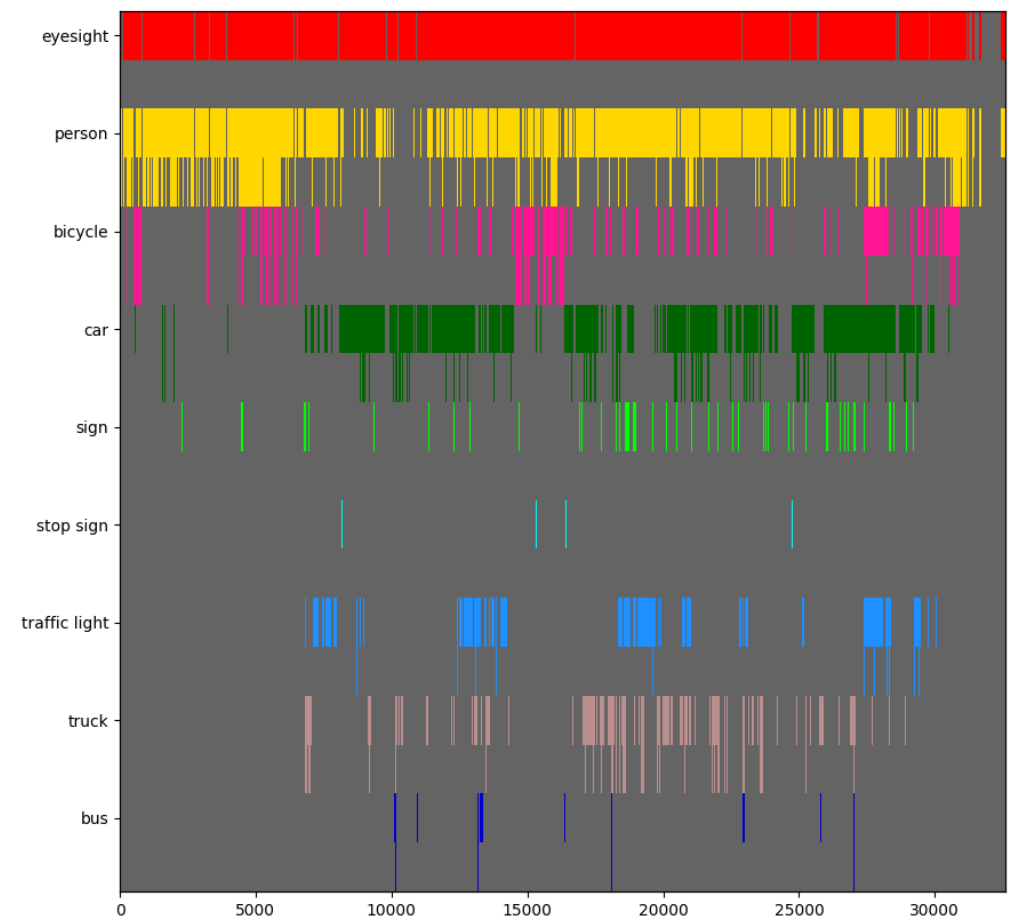
Figure 4 Objects looked at by a participant during a route